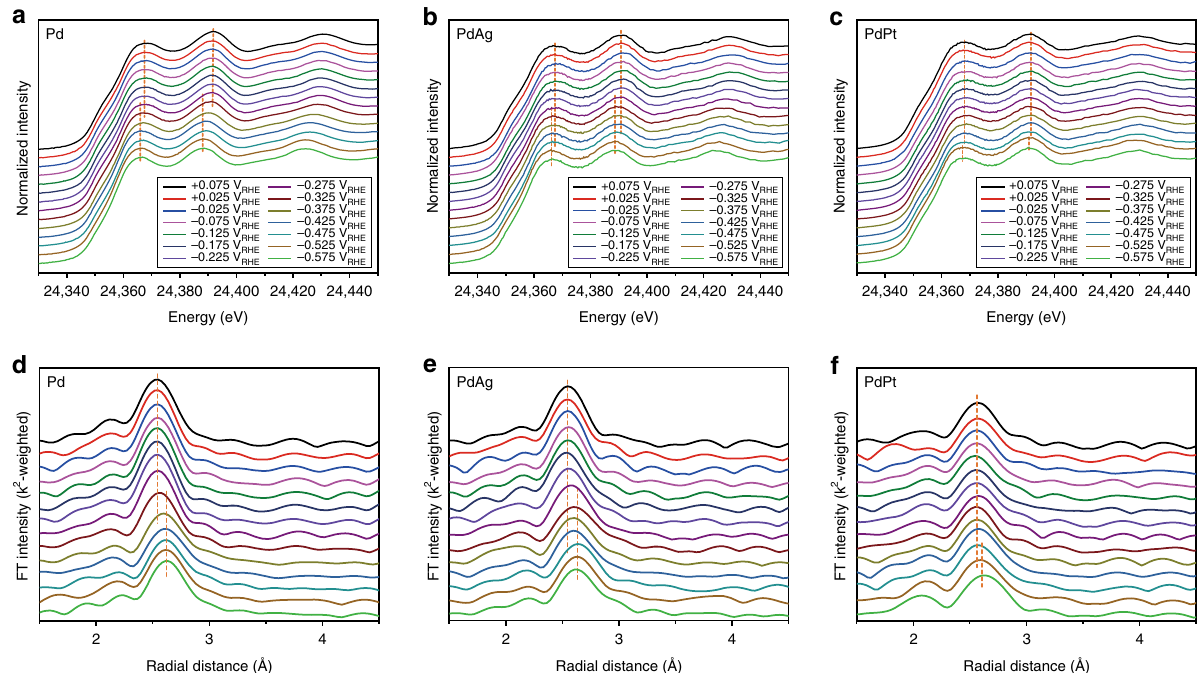
Fig. 2 In situ XAFS pro fi les measured at Pd K-edge. a – c Normalized XANES pro fi les for a Pd, b PdAg, and c PdPt. d – f k 2 -weighted EXAFS spectra for d Pd, e PdAg, and f PdPt